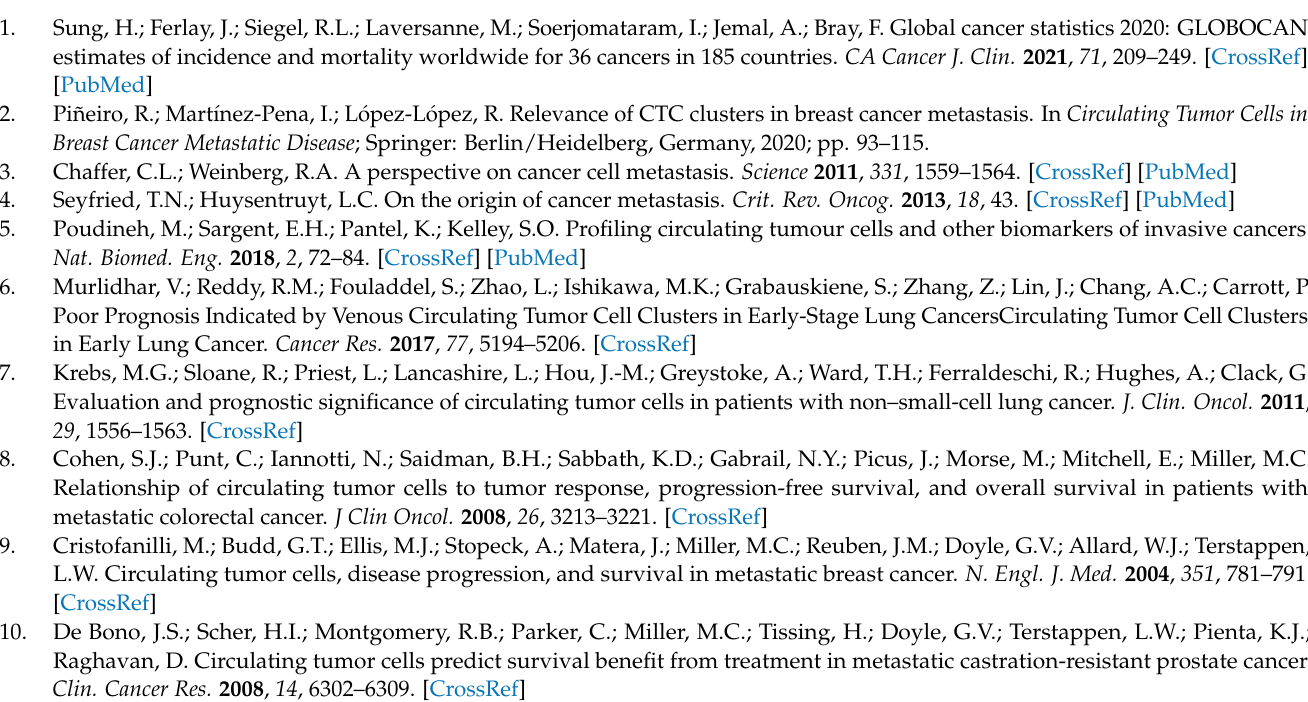
the gene expression. Scale bar, 100 µ m; Figure S2: Immunofluorescence staining for ITGA5 (green), FAP (red) and pan-CK (blue) in fresh mouse blood mixed with HMFs and MDA-MB-231 breast tumor cells, while Hoechst (white) represents nuclear staining. Strong unspecific binding of FAP in blood was shown. Scale bar, 40 µ m; Figure S3: (A) Gene expression of ITGA5 in pancreatic stellate cells (PSCs) with non-activation or activation with TGF β or conditional medium collected from pancreatic cancer cells, and Mia paca2 pancreatic cancer cells. (B) Immunofluorescence staining for ITGA5 (green) in non-activated and TGF β -activated PSCs as well as MIA PaCa2 pancreatic cancer cells, while Hoechst (blue) represents nuclear staining. Scale bar, 100 µ m; Figure S4: Immunofluorescence staining for collagen (green), in 6 mice implanted with tumor cells only. All mice showed collagen positive areas in their tumor slices, indicating the existence of CAFs which might be from EMT of tumor cells or recruitment of host fibroblasts. Scale bar, 100 µ m; Table S1: Antibody used and corresponding